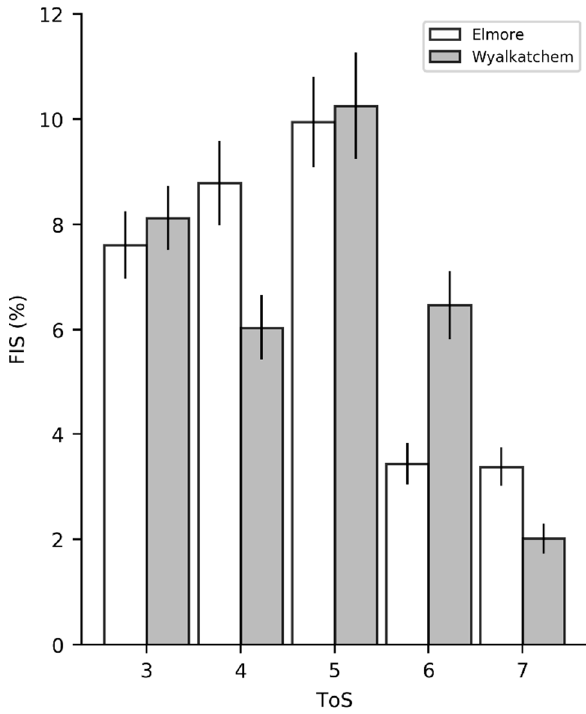
Figure 8. Mean FS in ToS 3,4,5 and 7 for both Wyalkatchem and Elmore in 2017, with standard error bars of the mean ( n = 90, 30 heads from each replicate, 3 replicates per ToS).